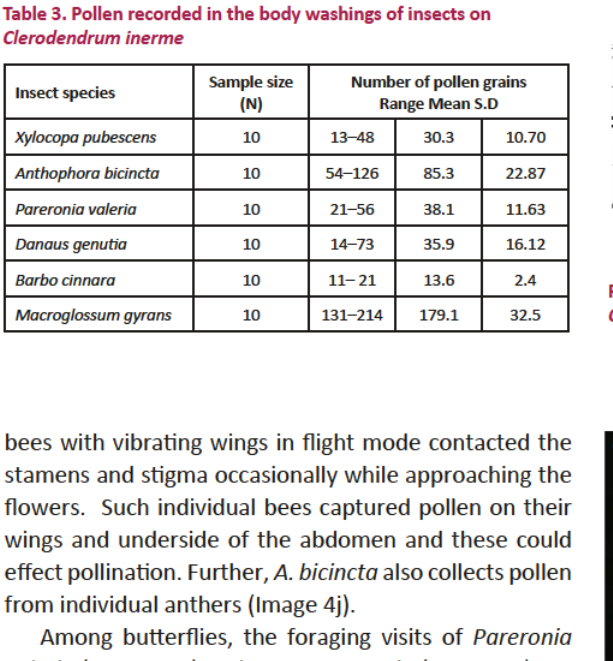
Figure 3. Foraging visifts off differenft caftegories off insecfts on Cflerodendrum